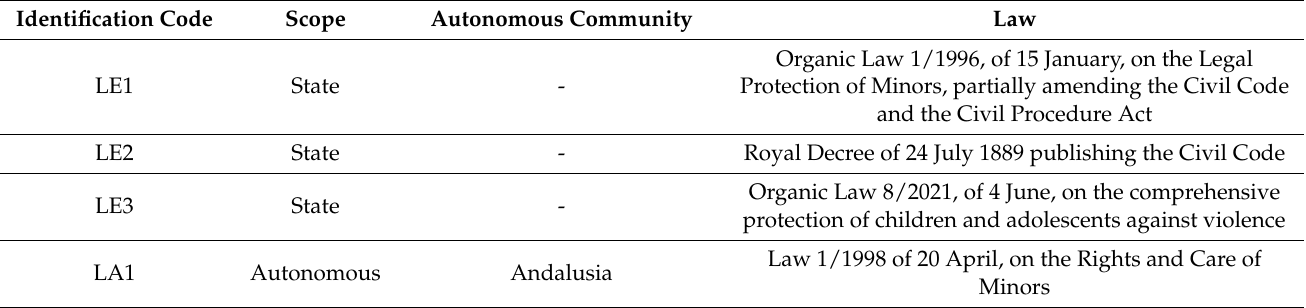
Table A1. Analysed Spanish legislation